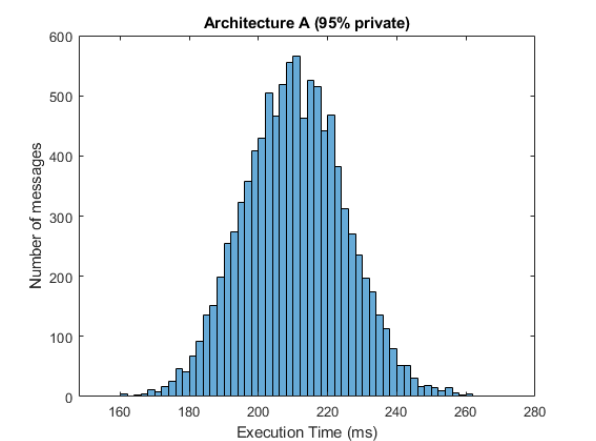
Figure 10. Histogram for architecture A (95% private messages).